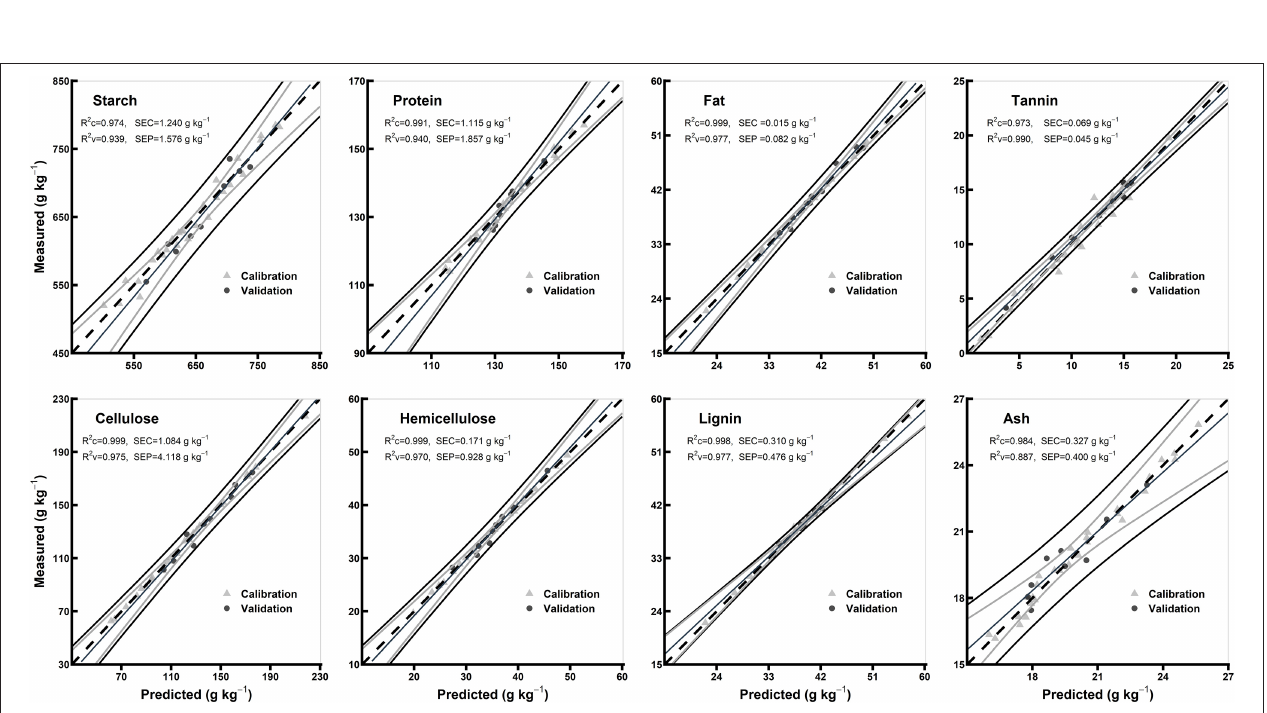
FIGURE 6 | Comparison of scatter plots of measured vs. predicted values (g kg − 1 ) of the hulled grain flours for starch, protein, fat, tannin, cellulose, hemicellulose, lignin, and ash of sorghum grains for the external validation subsets based on PLSR models. The black and gray lines in plot showed mean, maximum, and minimum values while dotted lines showed average chemical composition between calibration and validation sample set.